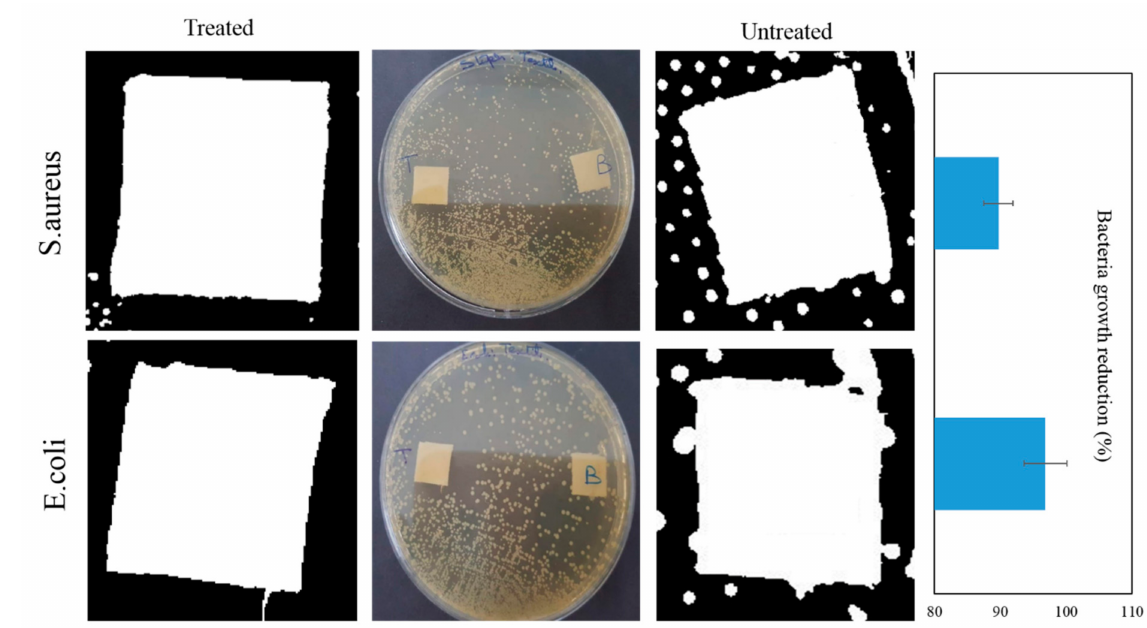
Figure 10. Antibacterial activity results of treated and untreated